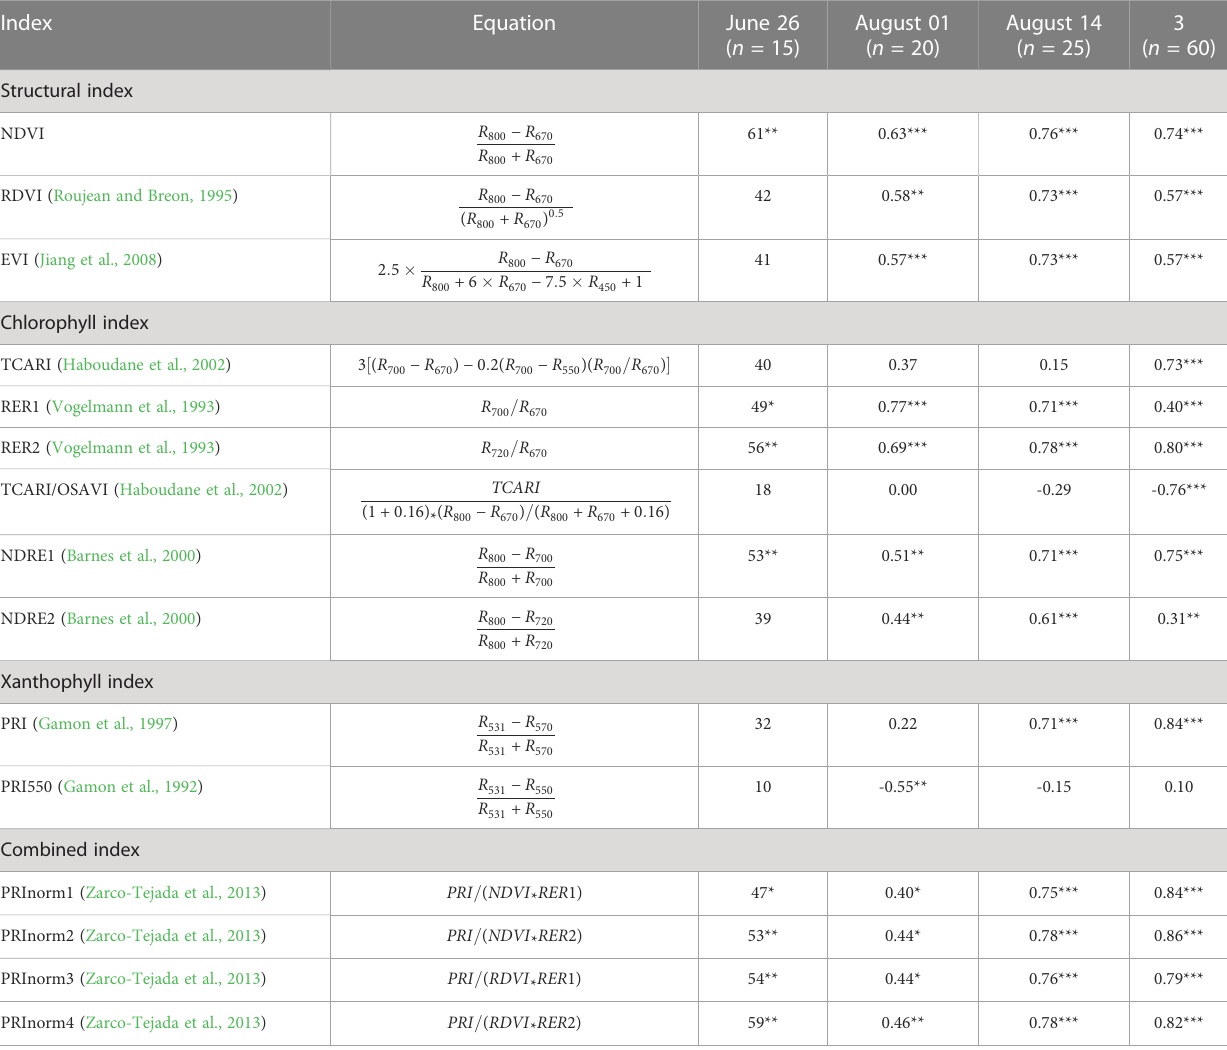
TABLE 2 The vegetation indices (VIs) calculated in this study, and the coef fi cients of correlation (r) between each VI derived from unmanned aerial vehicle imagery and measured stem water potential ( y stem ) for each individual fl ight and for all